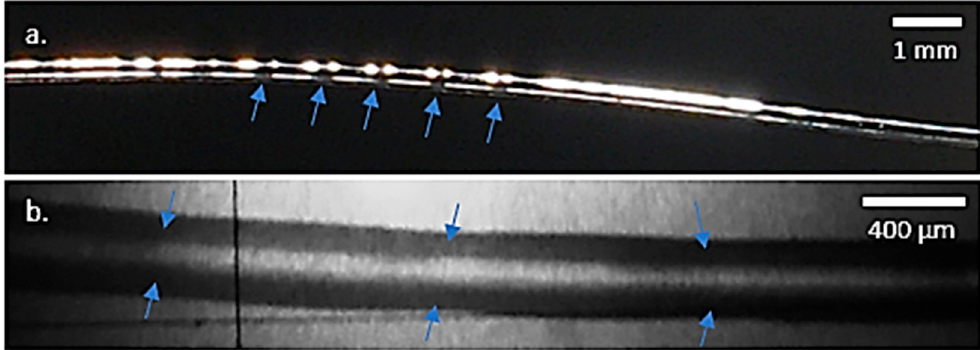
Figure 6. Optical microscope images: ( a ) wavy morphology on a filament extruded at 180 °C; ( b ) detailed wavy morphology, with valleys indicated with arrows.